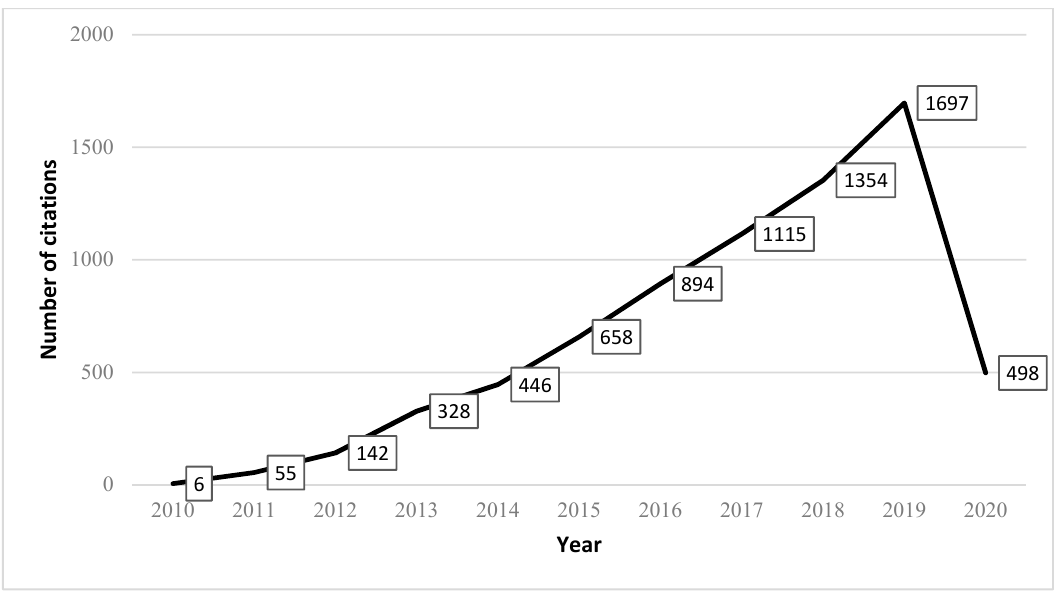
Figure 2. Number of citations received by research on energy efficiency in cloud computing (2009–2020). Source: authors’ own study. Data sourced from Scopus (20 May 2020).